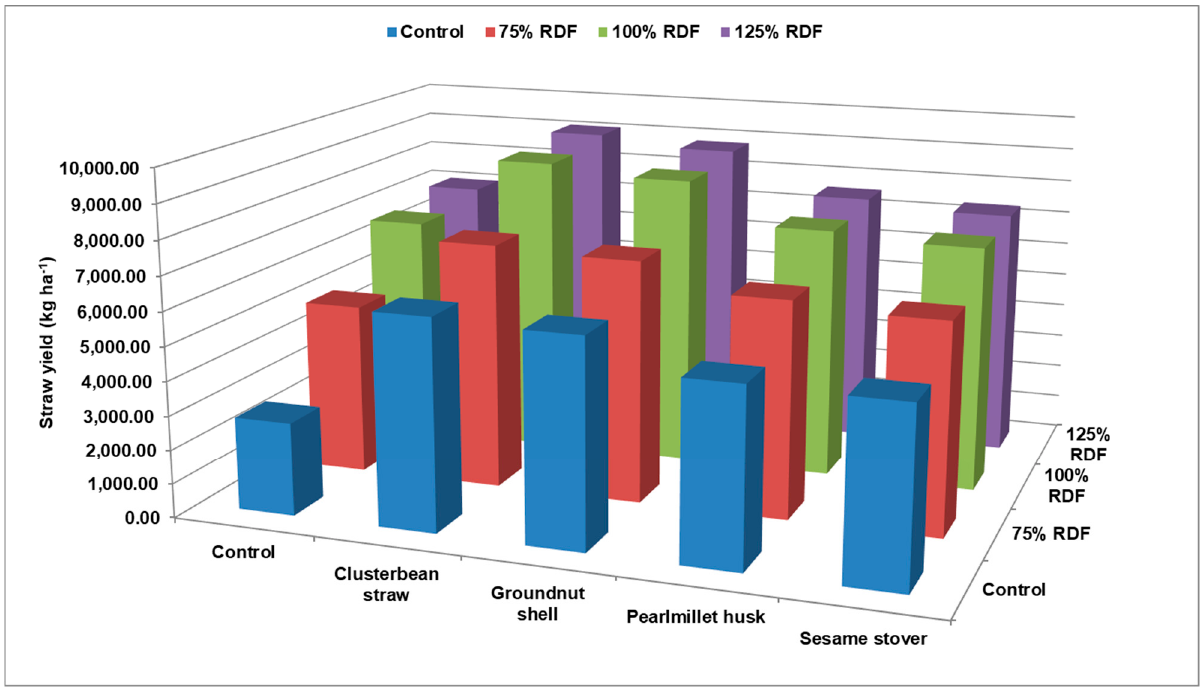
Figure 5. Interaction effect of crop residues and fertilization on straw yield of wheat.